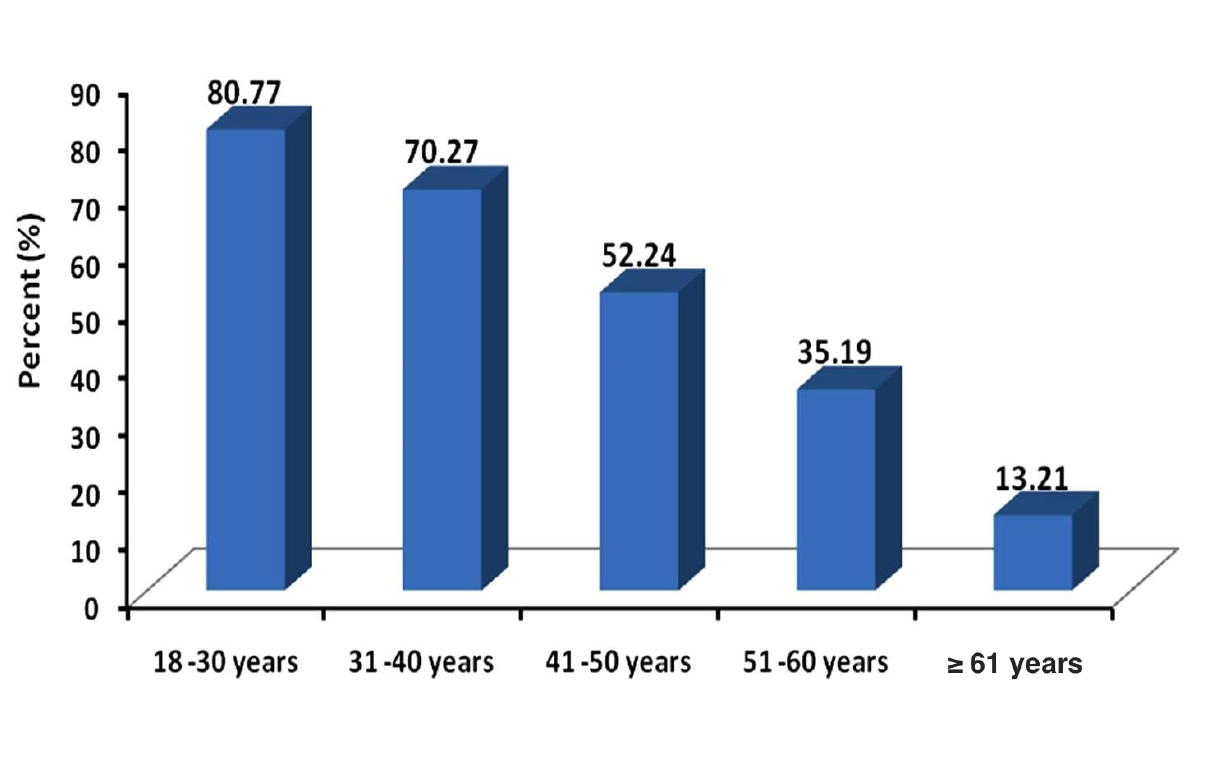
Figure 1. Distribution frequency of Internet use among diabetic patients by age.